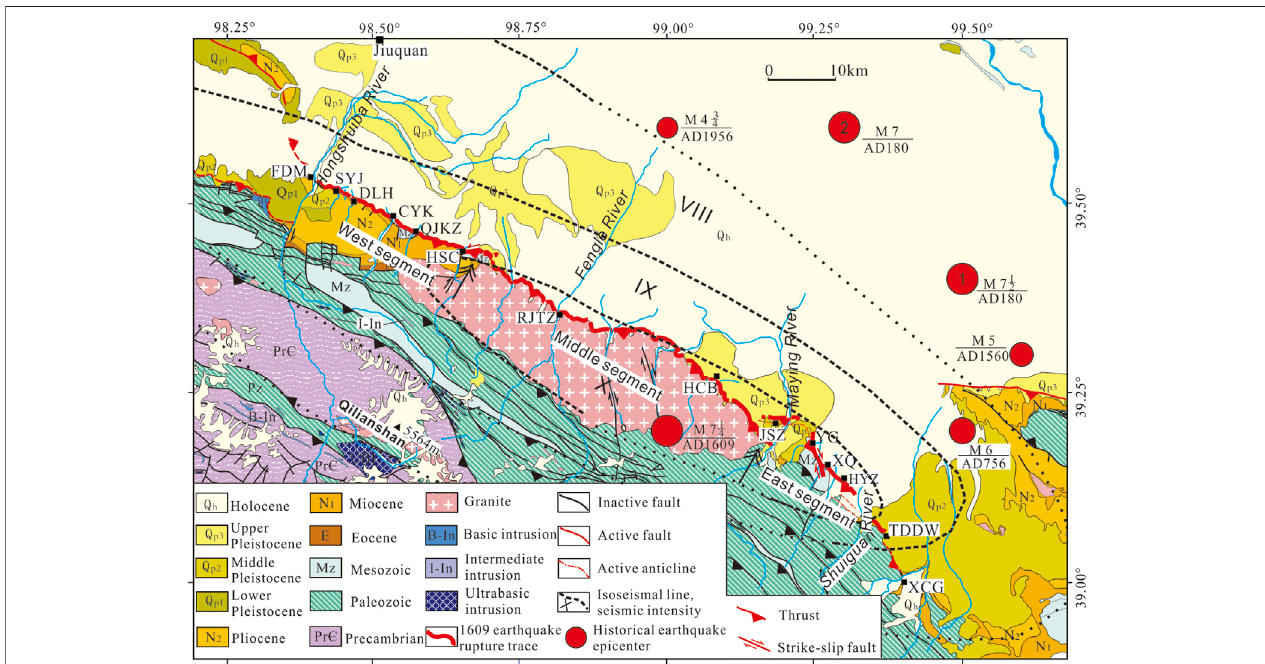
FIGURE2| GeologicmapacrosstheFodongmiao-Hongyazifault.Placenames:FDM,Fodongmiao;SYJ,Shiyangjuan;DLH,DalongRiver;CYK,Ciyaokou;QJKZ, Qujiakouzi; HSC,Hongshan Village;RJTZ,Rujiataizi; HCB, Huangcaoba; JSZ,JiashaziReservoir; YG, Yagou; XQ, Xiaoquan; HYZ,Hongyazi;TDDW,Toudaodongwan; XCG, Xichagou. The segmentation is according to Yang et al. (2017). The isoseismal lines of the 1609 earthquake are after Liu et al. (2011). Locations of historical earthquake epicenters, shown by red circles in the fi gure, are from the Earthquake Disaster Prevention Department and State Seismological Bureau (1995), Earthquake Disaster Prevention Department, China Earthquake Administration (1999), and Cao et al. (2010). The 180 AD M7.5 and 180 AD M7.0 data are for the same event but data vary in accordance with different estimates; these data are from the Earthquake Disaster Prevention Department and State Seismological Bureau (1995) and Cao et al. (2010),